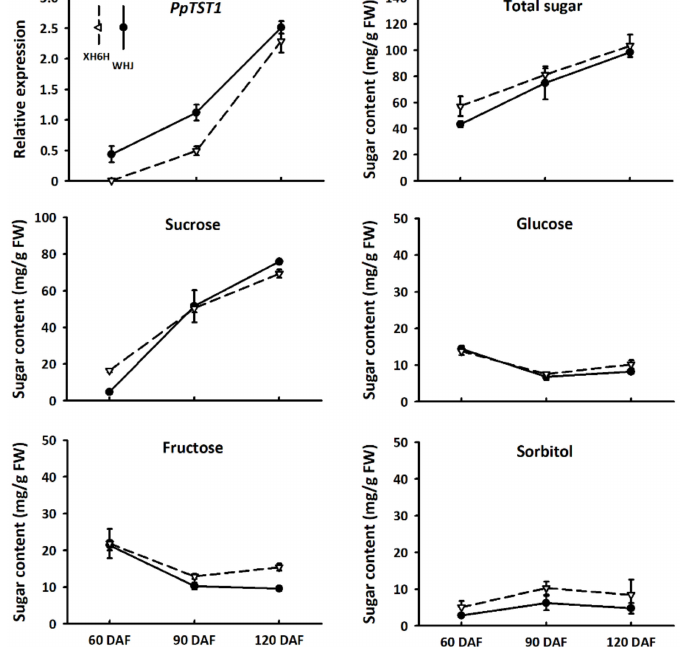
Figure 1. Relative expression of the PpTST1 gene, and accumulation of sugar components in peach fruits at di ff erent developmental stages. DAF, days after full bloom. Error bars represent standard error (SE) of three biological